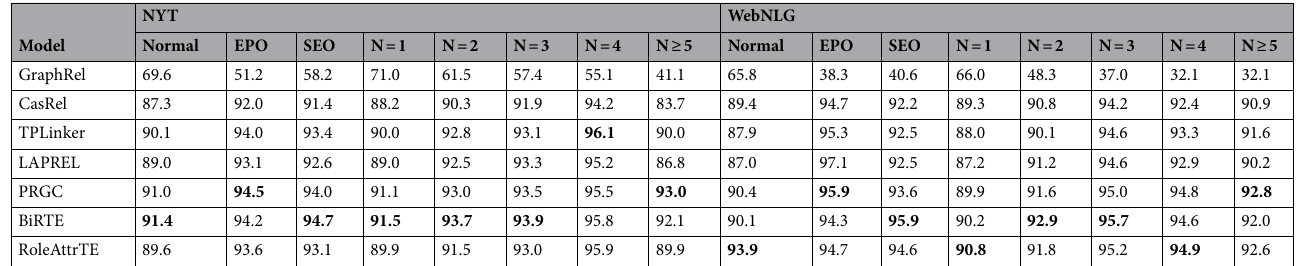
Table 6. F1 scores on sentences with different overlapping types and different numbers of